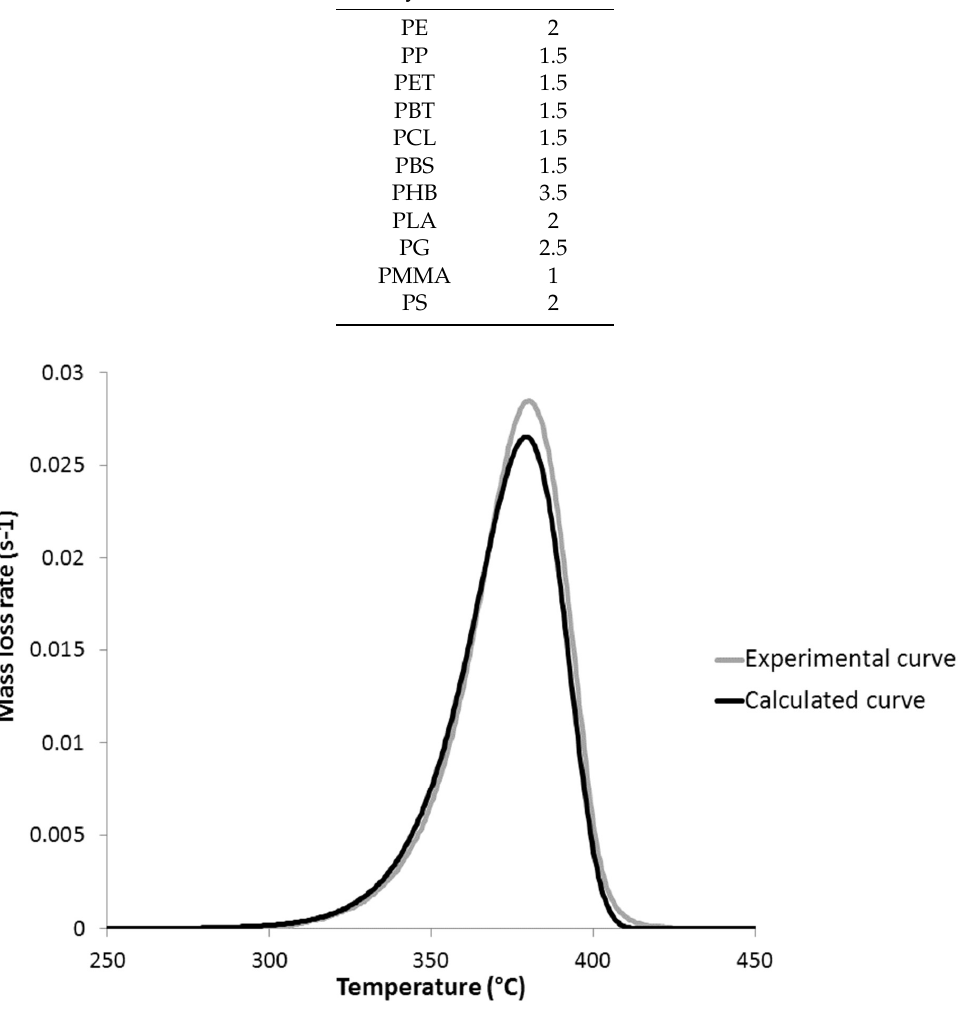
Table 4. Values of the parameter n for all studied polymers. Polymer